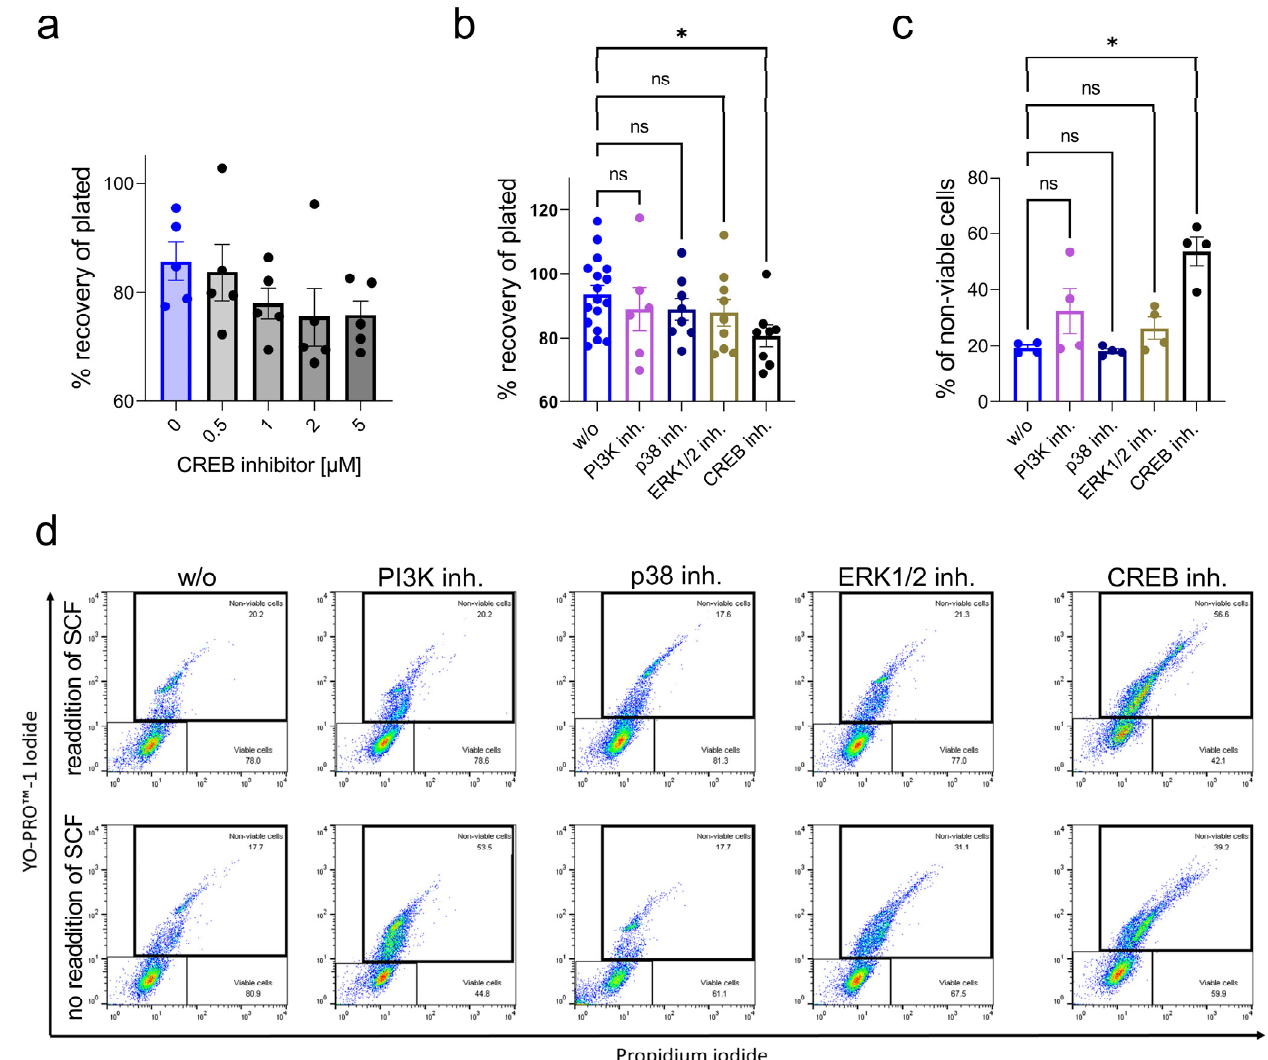
Figure 5. CREB function is required for skMC survival—comparison with other signaling modules. ( a ) SkMCs were treated with different concentrations of the CREB inhibitor for 2 d. Cell numbers were determined and are expressed as % of the original numbers plated. ( b ) As in ( a ), but inhibitors of critical kinases (PI3K, p38 and ERK1/2) were used for comparison. ( c , d ) SkMCs were treated with the specified inhibitors for 2 d and viable versus non-viable/apoptotic cells were determined with the YoPro/PI technique. To one portion, fresh SCF was provided directly upon inhibitor pretreatment, the other part had SCF from the previous feeding only (3–4 d earlier). ( c ) Cumulative results. ( d ) Representative dot plots: upper panel with re-addition of fresh SCF, lower panel without. Each dot in ( a – c ) corresponds to an individual experiment. * p < 0.05 by the Kruskal–Wallis test ( b ) or by the Friedman test ( c ).